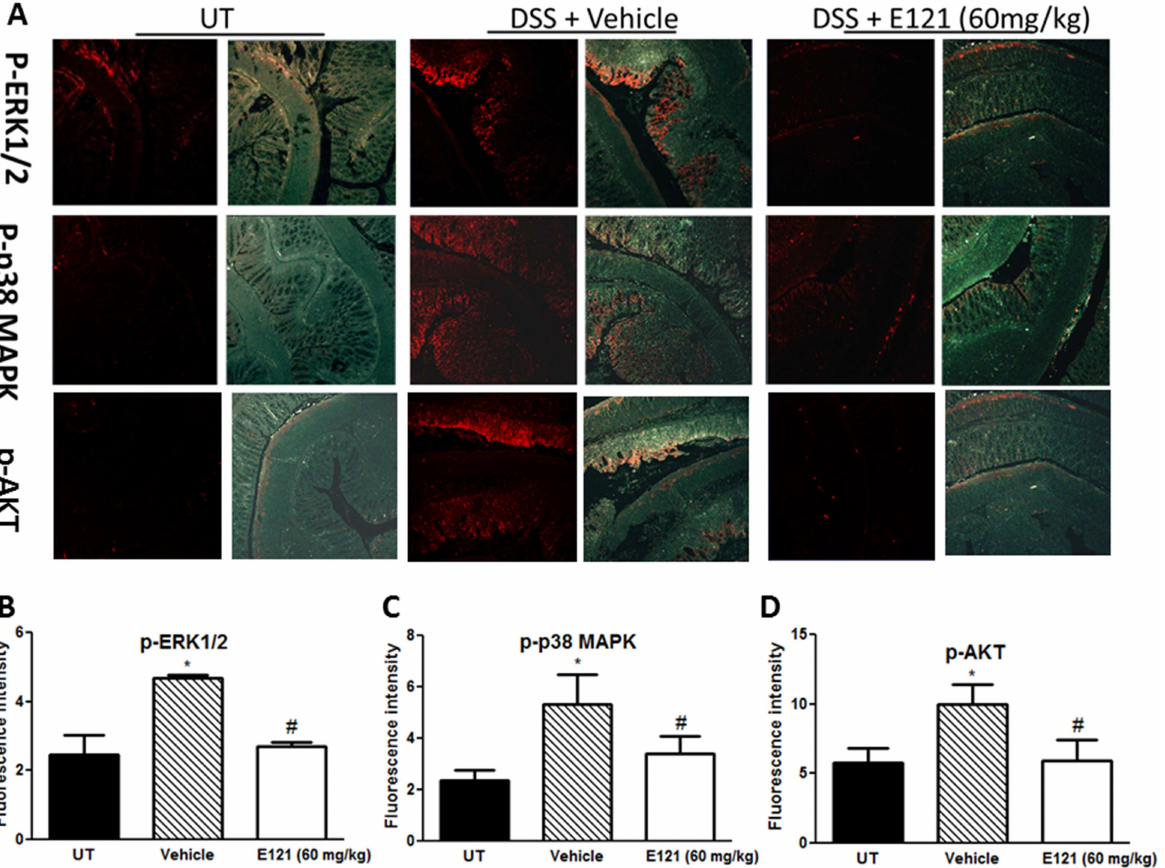
Fig 4. Effect of E121 on phosphorylation level of signaling molecules. Colonsections taken from untreated(UT) mice or mice treated with DSS for 5 days plus E121 (60 mg/kg) or vehiclewere immunostained with antisera againstphosphorylated ERK 1/2, p38 MAPK, and AKT (panelA). Immunofluorescent (Alexa Fluor) signalsshown in left side of panel A are overlaidwith DAPI stain on right side to show tissue architecturefor the conditionsindicated.PanelsB-D represent quantitative assessment of fluorescence intensity (arbitrary units). Histobars represent means ± SEM for 4 mice in each group. Asterisk denotessignificantdifference from UT mice, with p < 0.05,and # denotes significantdifference from DSS/ i.p vehicletreated mice, with p <